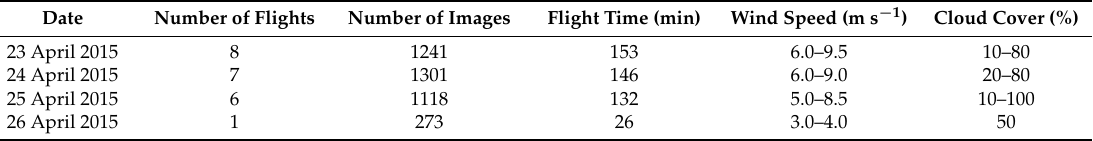
Table 2. Summary of flight characteristics for each flight block of imagery